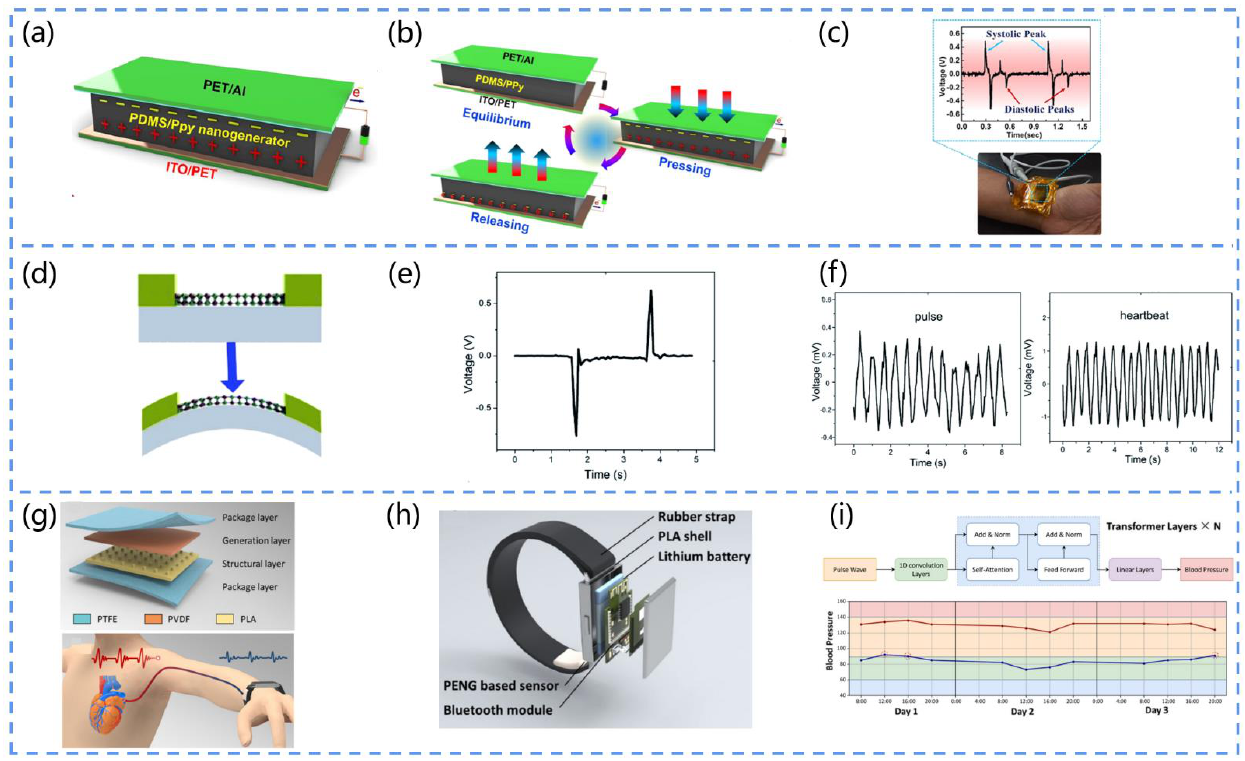
Figure 11. ( a ) Schematic diagram of the structure of the PDMS/PPy-based PENG. ( b ) Diagram of the operating mechanism of the PDMS/PPy-based PENG. ( c ) The voltage response of the PDMS/PPy- based PENG as arterial pulse pressure, the blue arrow represents the peak systolic pulse and the red arrow represents the peak diastolic pulse. Reprinted with permission from [137]. Copyright 2022, Elsevier. ( d ) Schematic diagram of the structure of the SnSe-based PENG whilst bent (The arrows represent the direction force action). ( e ) The output voltage of the SnSe-based PENG reaches 760 mV. ( f ) The heart rate is detected with the device attached to the wrist and chest. Reprinted with permission from [139]. Copyright 2021, the Royal Society of Chemistry. ( g ) Material and sensing schematic of BPPW. ( h ) Component modules of BPPW. ( i ) Deep learning model construction of BPPW and application for the prediction of blood pressure among test subjects (The blue line rep- resents the patient's blood pressure and the dotted line represents the moment when it exceeds the normal value). Reprinted with permission from [141]. Copyright 2022, MDPI.